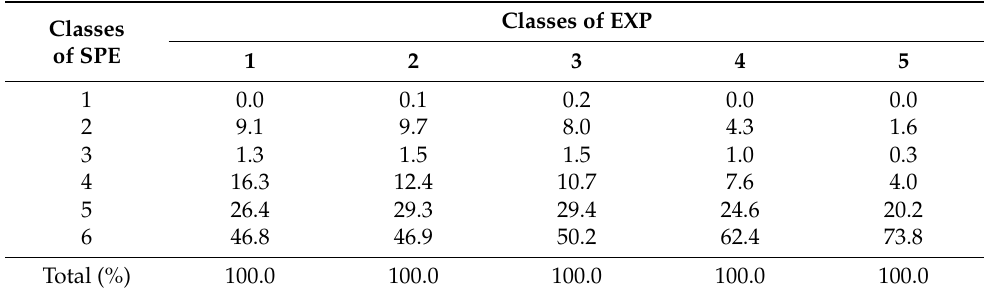
Table 10. Percentage incidence of every SPE classes within the same EXP class (calculated as percentage of LAUs’ number for each SPE class into the same EXP class on the total number of LAUs falling in that EXP class) for data of the first census date (C1).